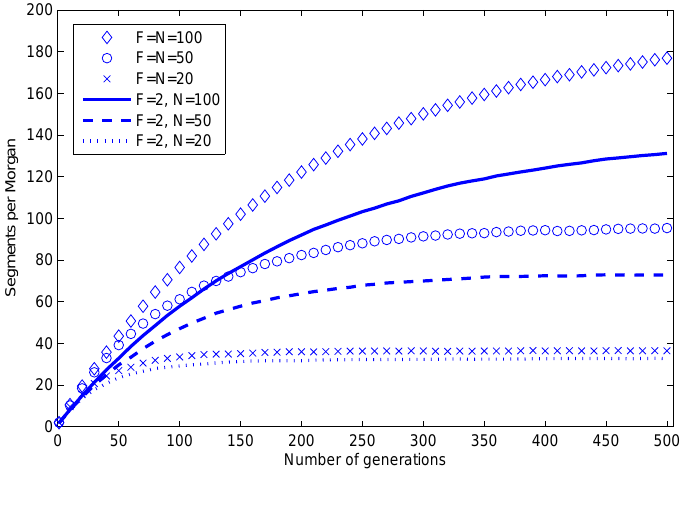
Figure 3. Average number of segments per one Morgan in a haploid during 500 generations in simulations of random mating populations. F is the number of individuals in the founder population, and N is the number of individuals in every subsequent population. The parents of each progeny are chosen at random (with replacement) from the previous generation.